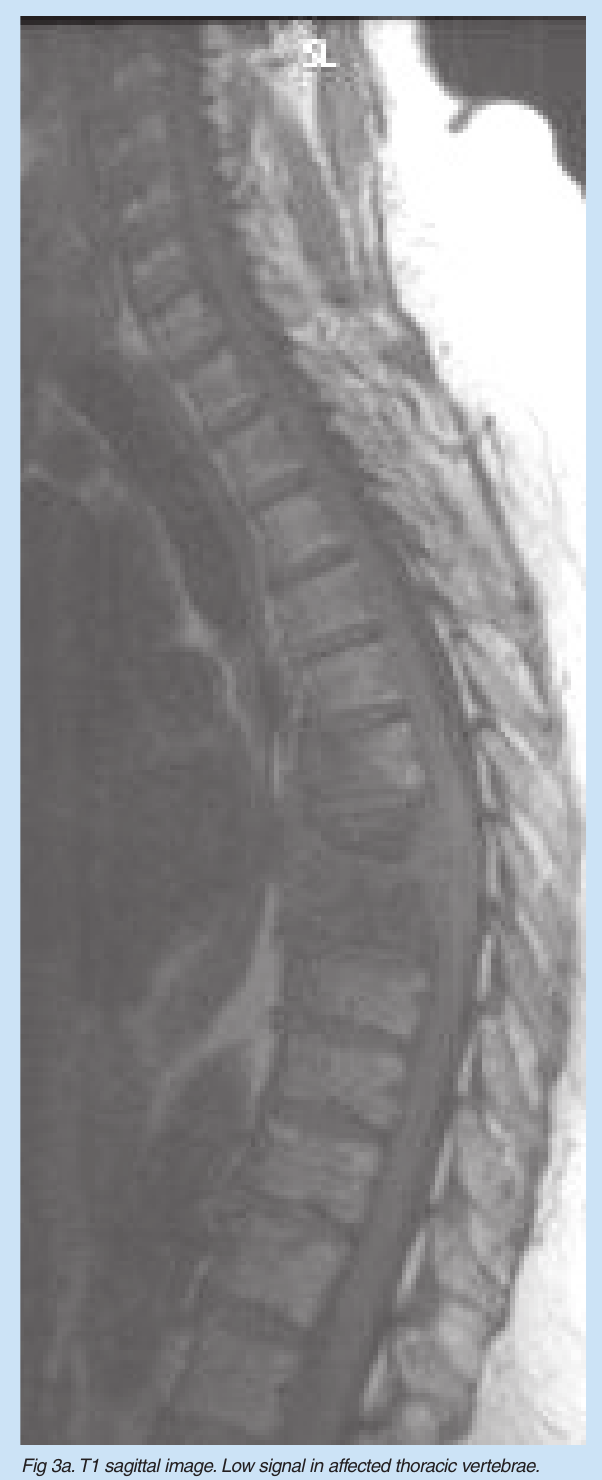
Fig 3a. T1 sagittal image. Low signal in affected thoracic